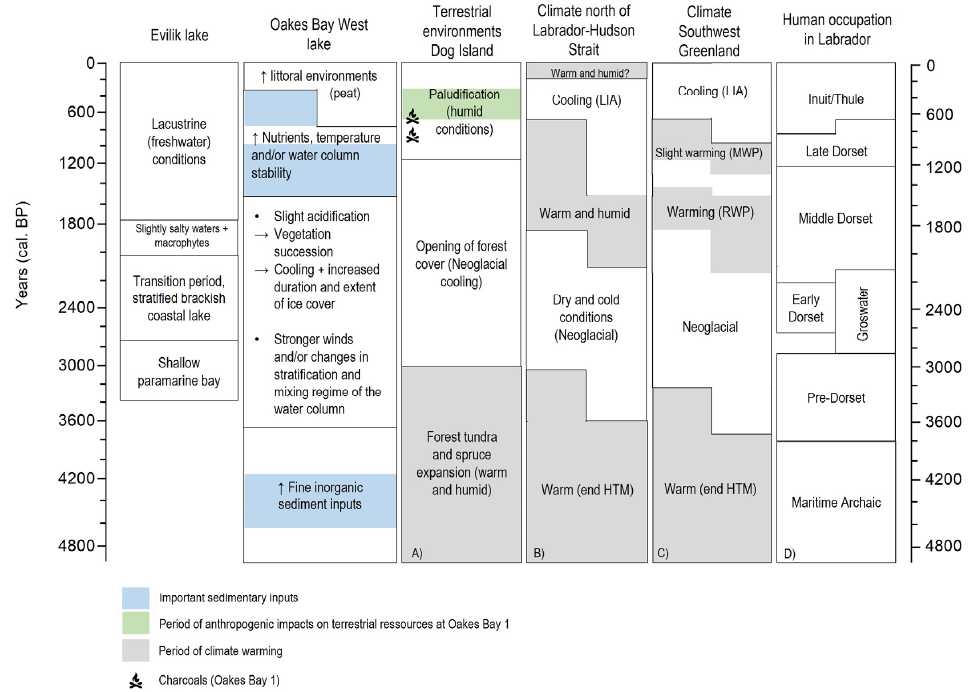
Figure 8. Key results from Oakes Bay West and Evilik lake cores in comparison to ( A ) the evolution of Dog Island terrestrial landscape [5], ( B ) palaeoclimatic conditions in northern Labrador and Hudson Strait [6,93,94,118,119], ( C ) palaeoclimatic conditions in southwestern Greenland [89,90,92,95],